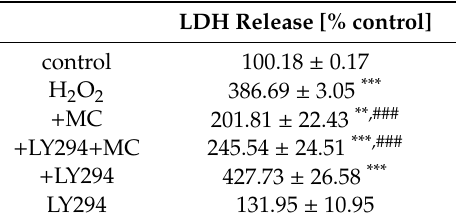
Table 2. The e ff ect of PI3-K inhibitor (LY294002) on the methyl ca ff eate-mediated protection against the hydrogen peroxide-induced cell damage in UN-SH-SY5Y